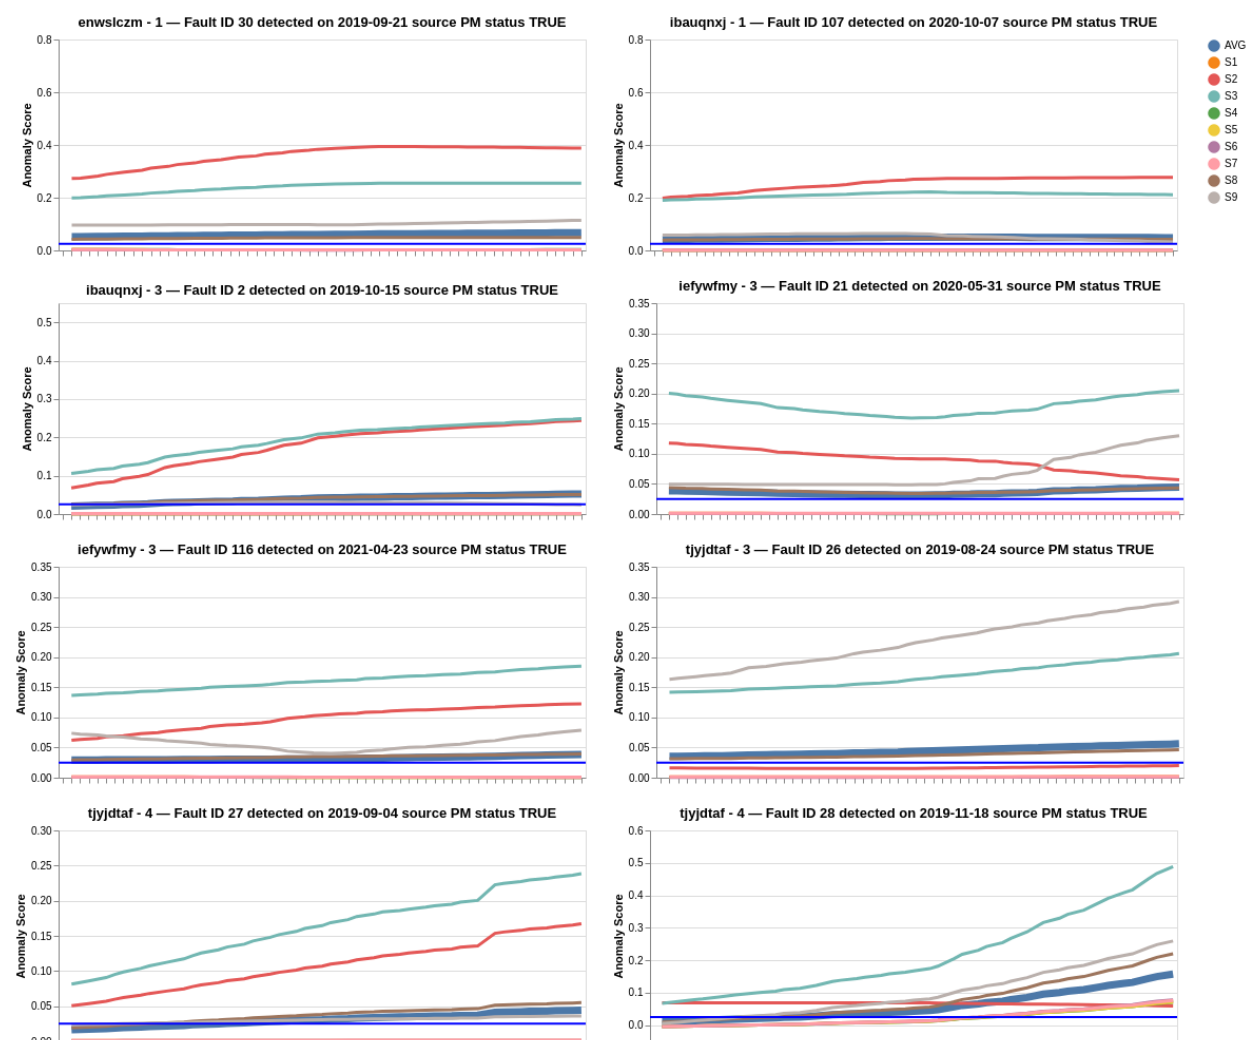
Figure 19. Run-to-failure computed in run lstmae_pca_10 for the test